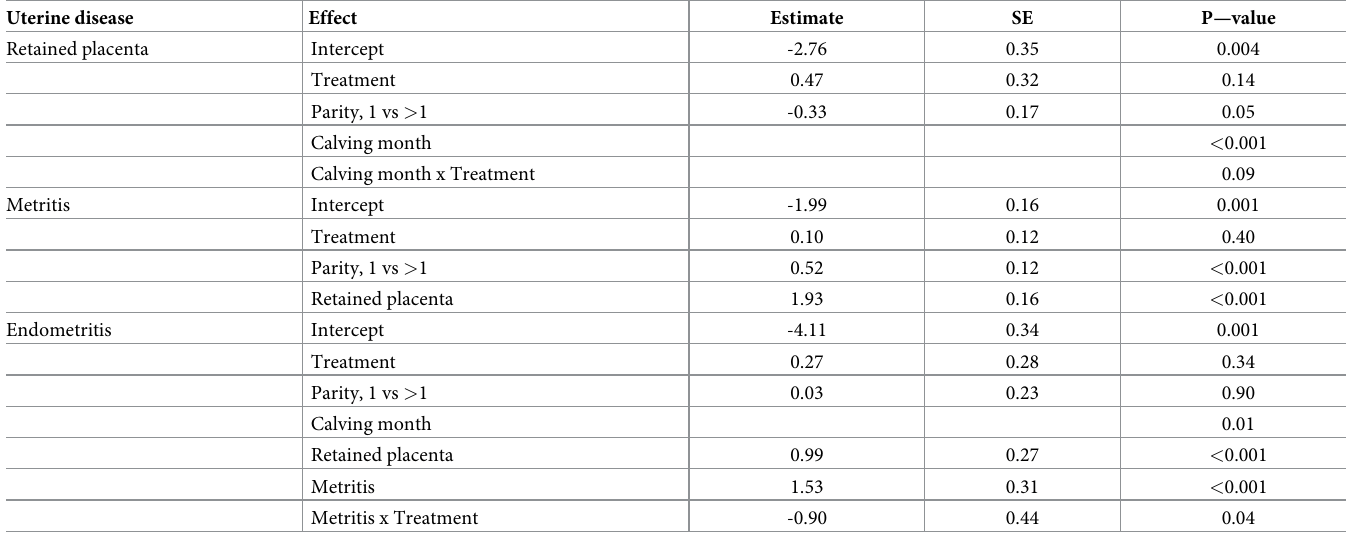
Table 5. Regression analysis model results for uterine disease. Uterine